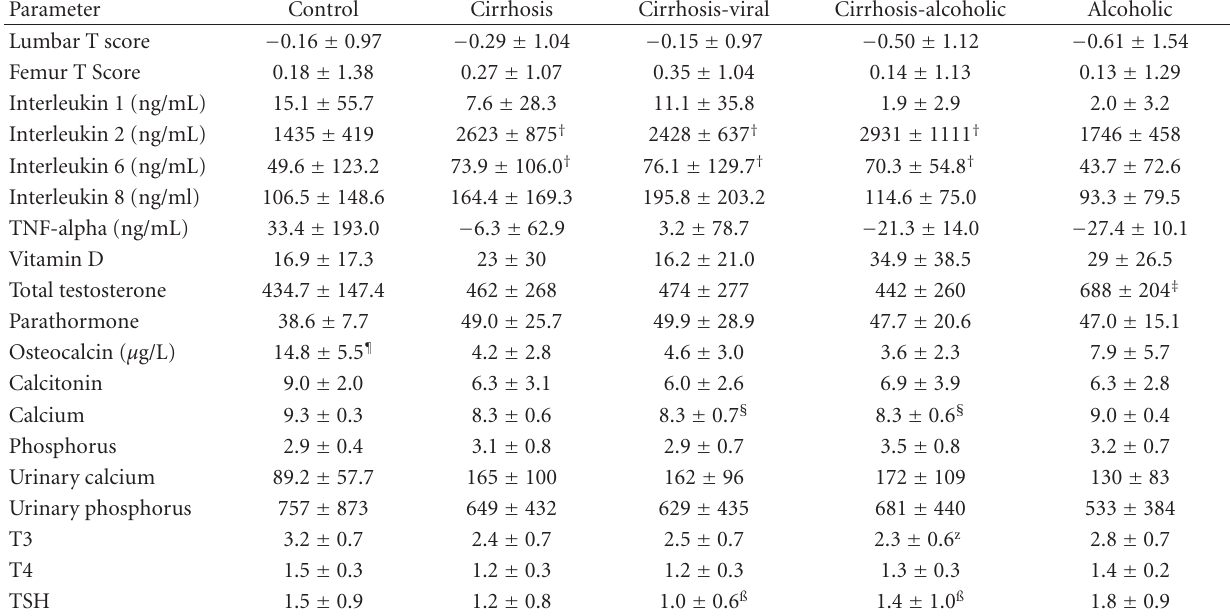
Table 2: Lumbar and femur T-scores, cytokines, hormones and bone metabolism data ∗ of the study